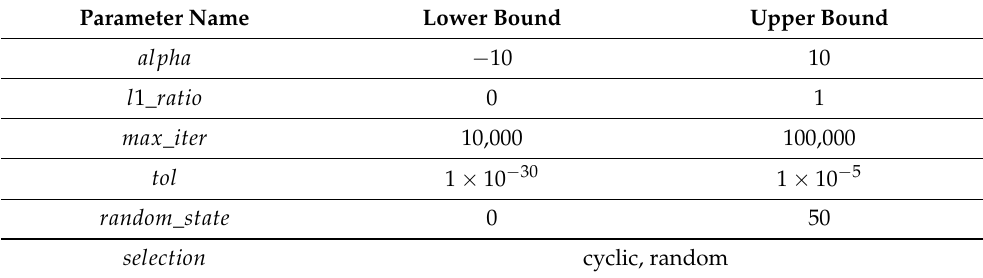
Table 5. An overview of the used hyper-parameter range for ElasticNet Regression